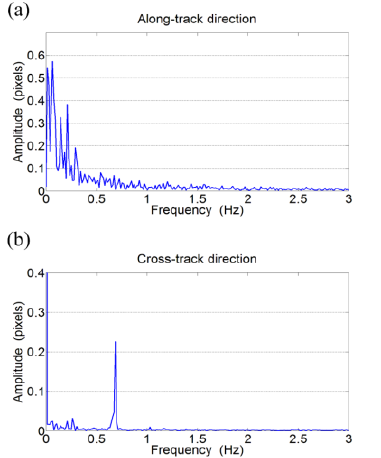
Figure 6. The spectrograms of the mean parallax